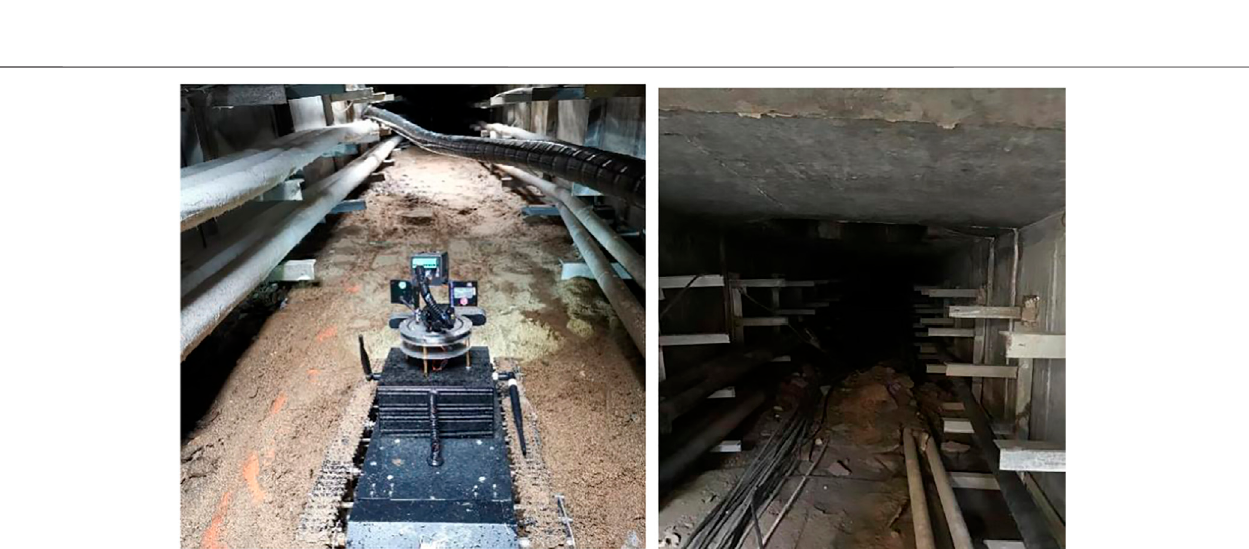
FIGURE 8 | Hanging cable (left); accumulation of rubble and building materials